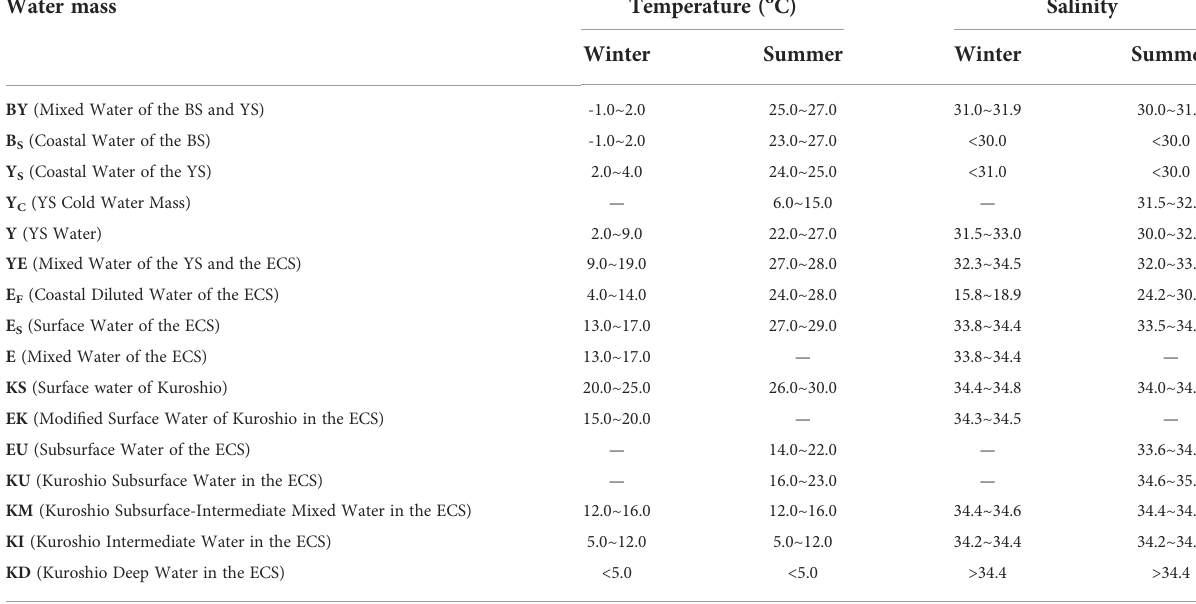
TABLE 2 Temperature and salinity ranges of water masses in the Bohai Sea, the Yellow Sea and the East China Sea. Water mass Temperature ( o C) Salinity Winter Summer Winter